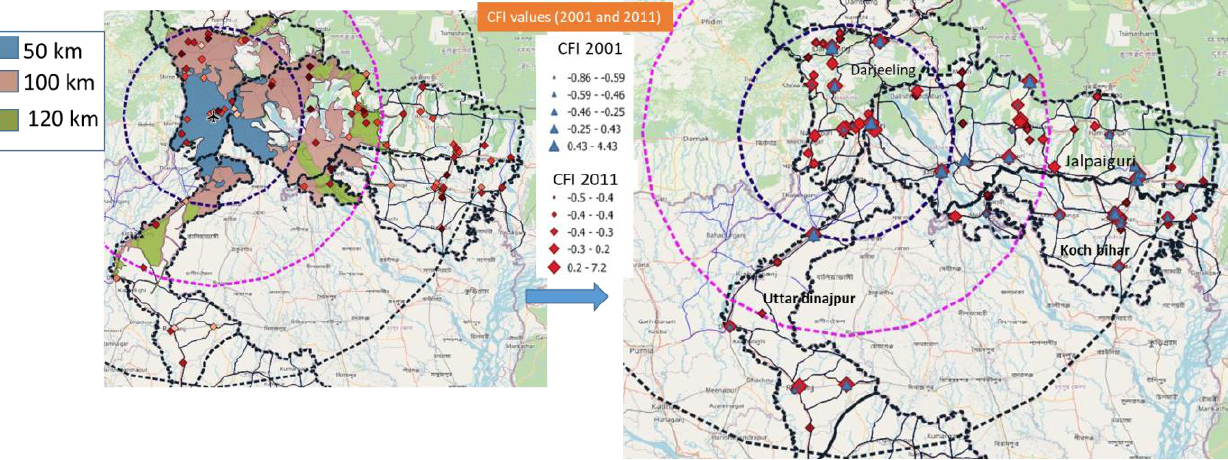
Figure 8. Functionality index of settlements for the years 2001 and 2011.